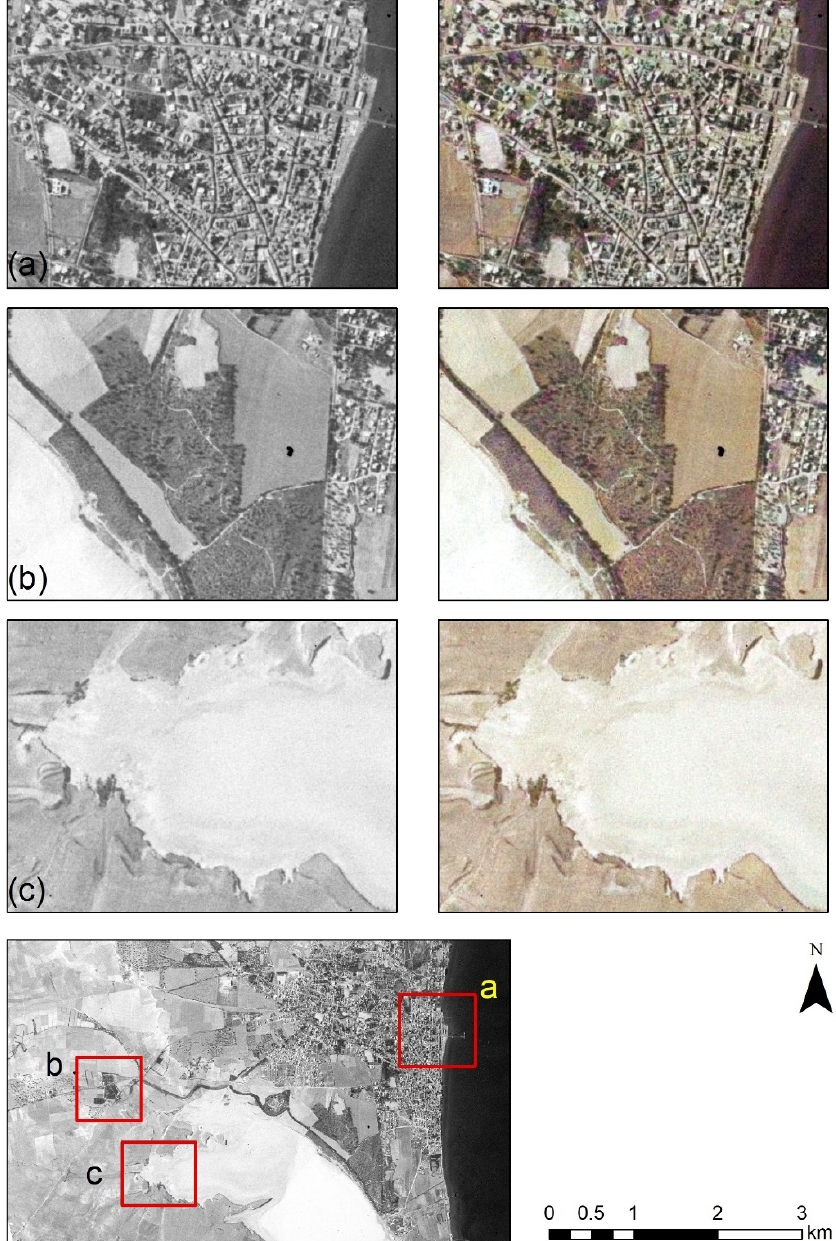
Figure 4. A closer look at the colourised CORONA satellite image over Larnaca city ( a ), the surrounding agricultural area ( b ) and over the salt lake of Larnaca ( c ). The left column shows the original greyscale CORONA image, while the right column shows the colourised image.